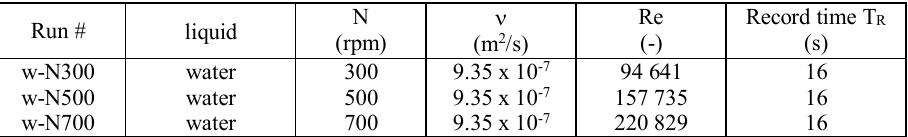
Table 1. Operational parameters.